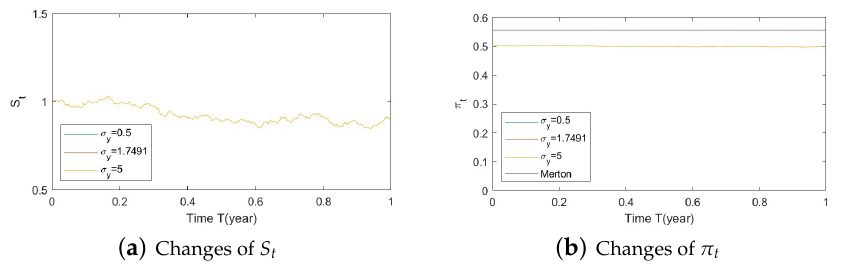
Figure A36. Illustrate the impact on ( a ) stock prices and ( b ) optimal stock allocations when varying σ y ( e . g ., σ y = 0.5,1.7491,5 )